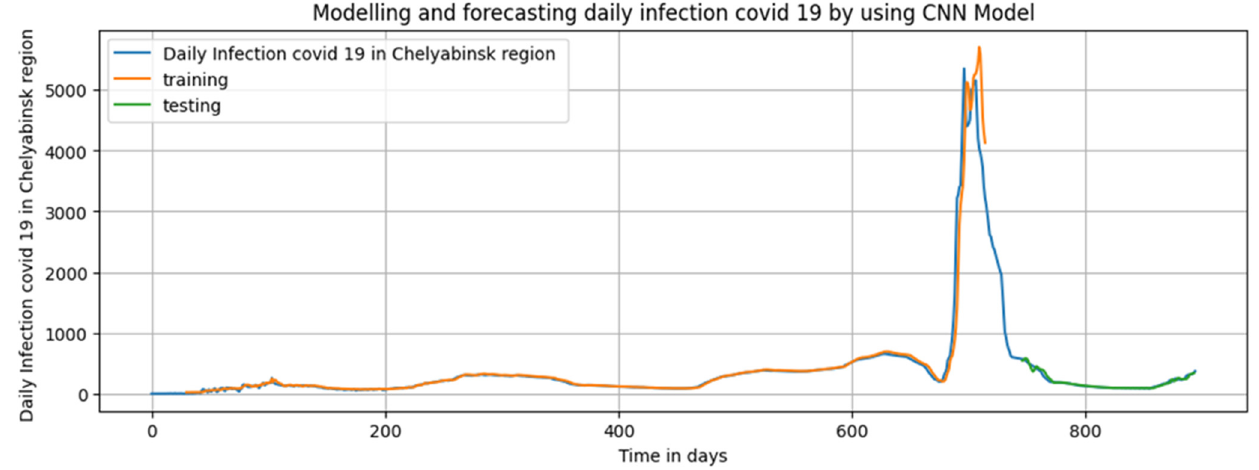
Figure 12. Comparison of the forecasting SARS-CoV-2 infection cases and the real infection cases for CNN.